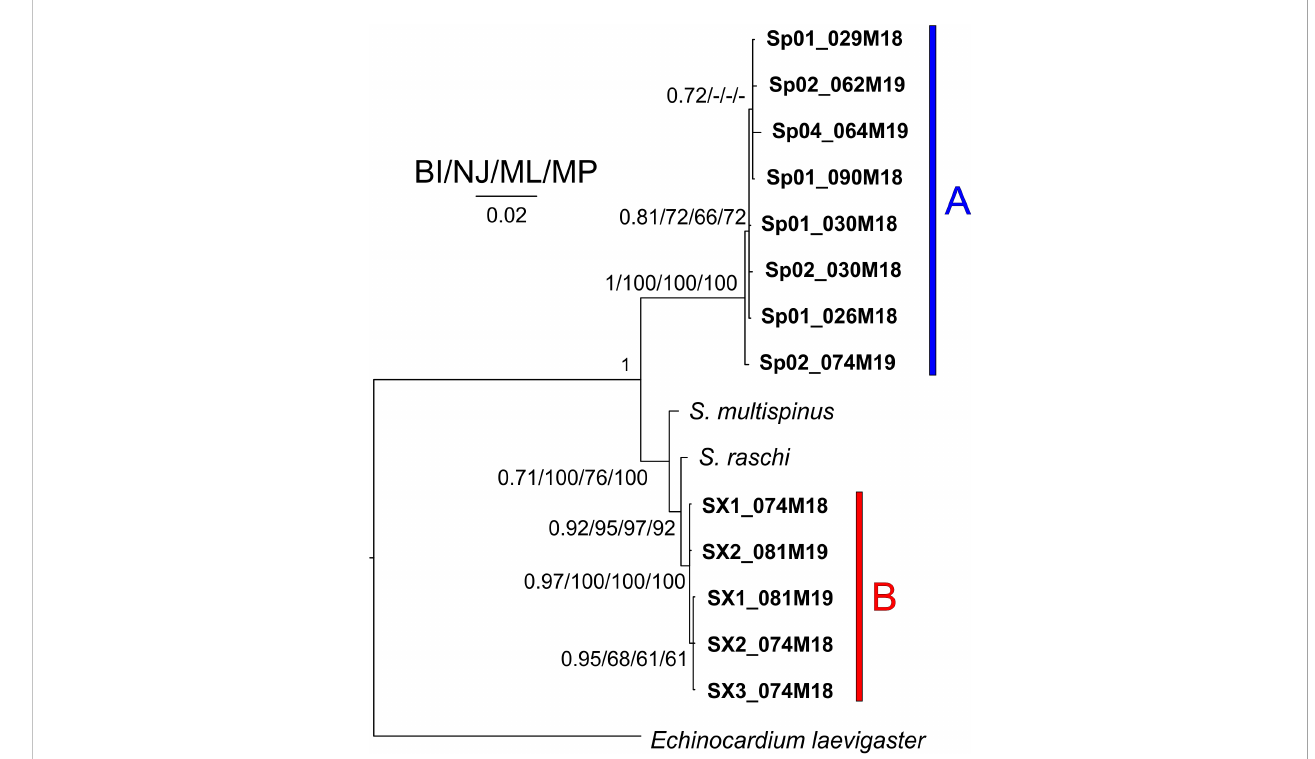
FIGURE 8 Tree obtained combining morphological and molecular characters. Near the nodes are the values for the Bayesian probability (BI) or the bootstrap support (NJ/ML/MP). In bold are the Sardinian spatangoids. The bar and capital letters A (blue) and B (red) indicate the sequences of morphotype A and B,